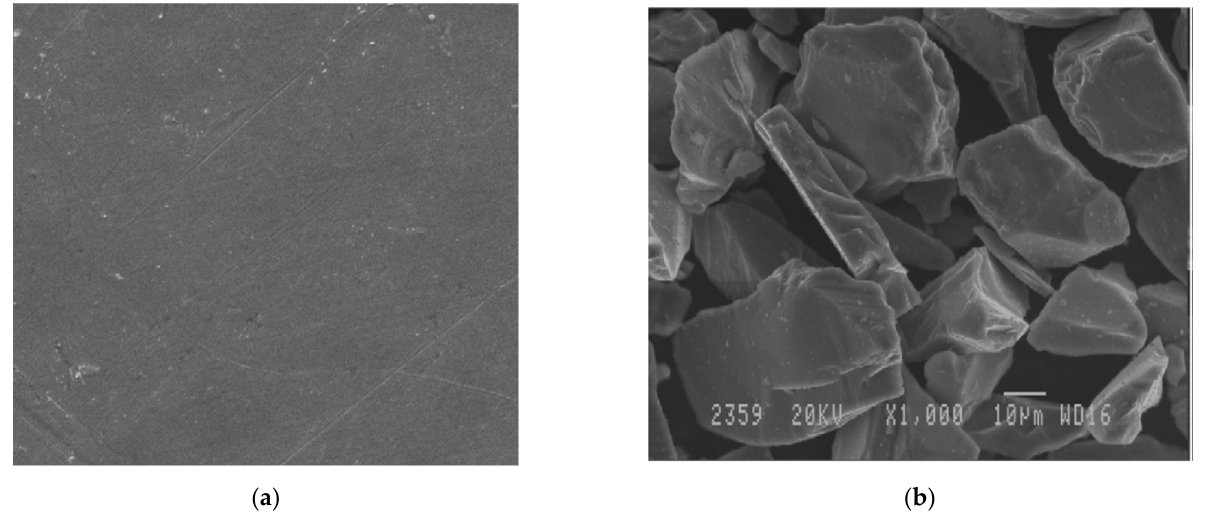
Figure 2. ( a ) Scanning electron micrograph of AA 6061 alloy; ( b ) Scanning electron micrograph of silicon carbide powder [35].